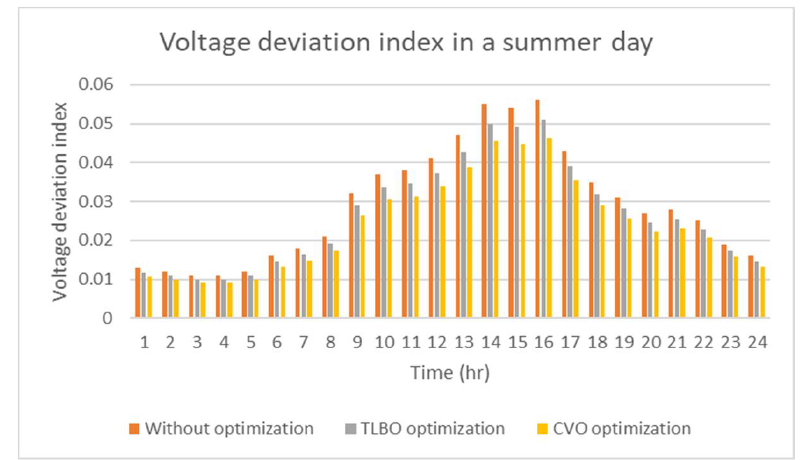
Figure 7. Total power losses and voltage deviation index in a summer day.